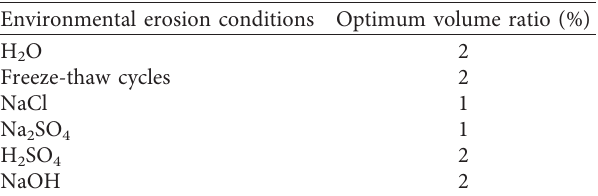
Table 4: Optimum content of steel fiber in different erosion environments.